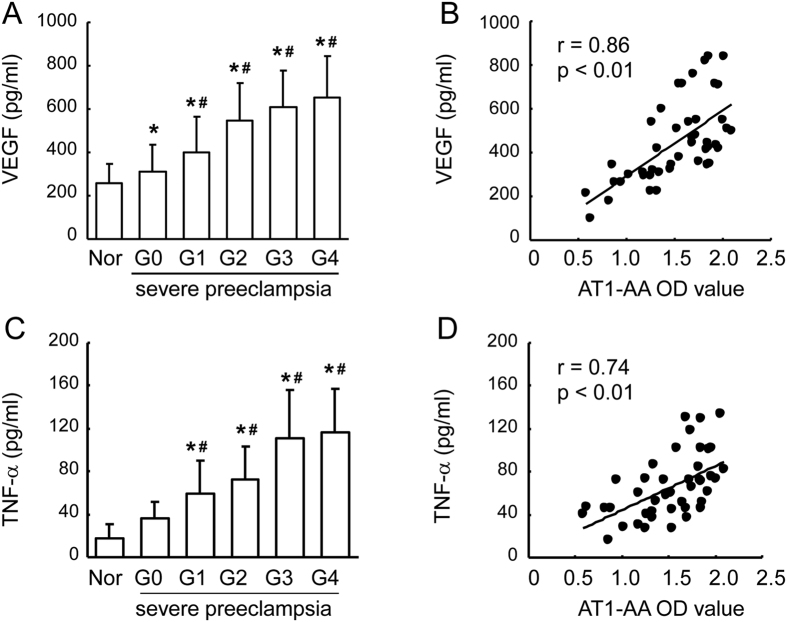
Plasma VEGF and TNF-α level in severe preeclampsia and normal pregnancy groups.Increased level of VEGF was detected in retinopathy grade (A,C). Scatter plots show a positive linear correlation between plasma VEGF and TNF-α level and AT1-AA titer in severe preeclampsia (B,D). Values are mean ± SD. *p < 0.05 vs. normal pregnancy group (Nor); #P < 0.05 vs. grade 1, respectively.